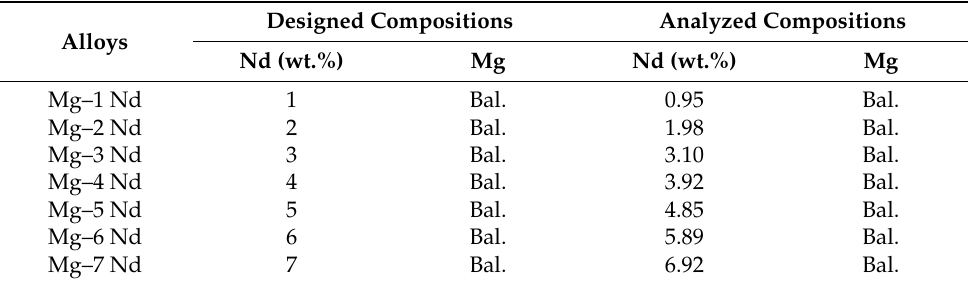
Table 1. Chemical compositions of Mg– x Nd alloys. Designed Compositions Analyzed Compositions Alloys Nd (wt.%) Mg Nd (wt.%)